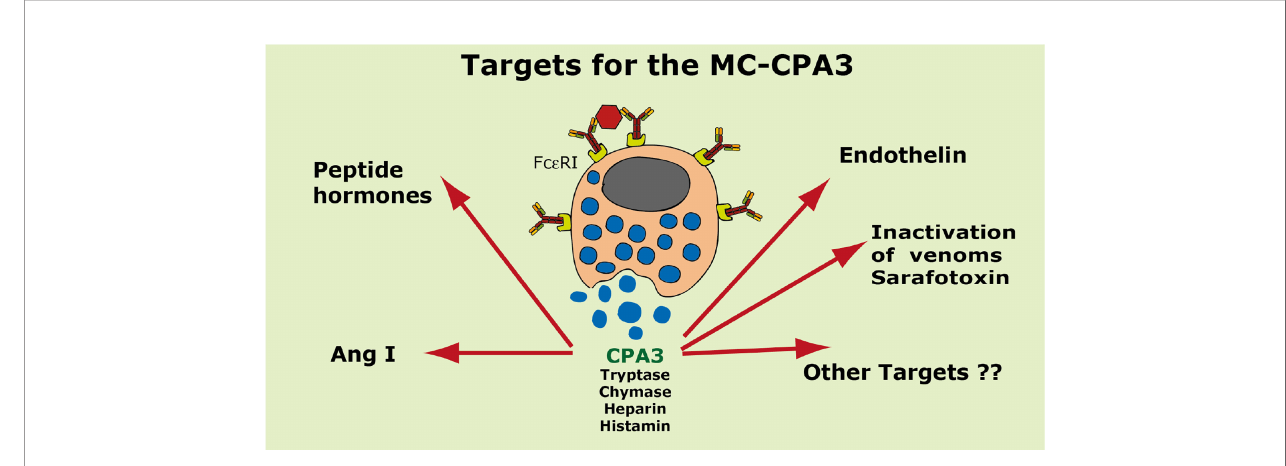
FIGURE 8 | Targets for the human MC-CPA3. A number of potential targets for the human MC carboxypeptidase A3 (CPA3) is